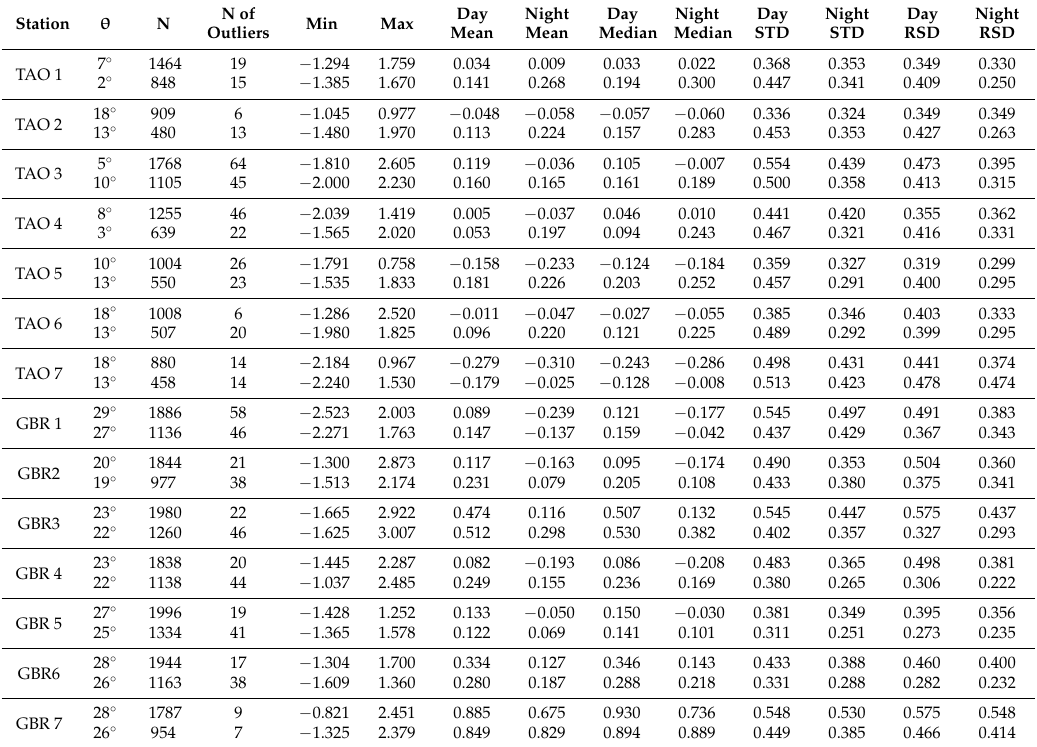
Table 4. Statistics of satellite Sea-Surface Temperature (SST)—in situ temperatures (K). Upper row for each station is for Himawari-8 SSTs, and the lower row for MTSAT-2